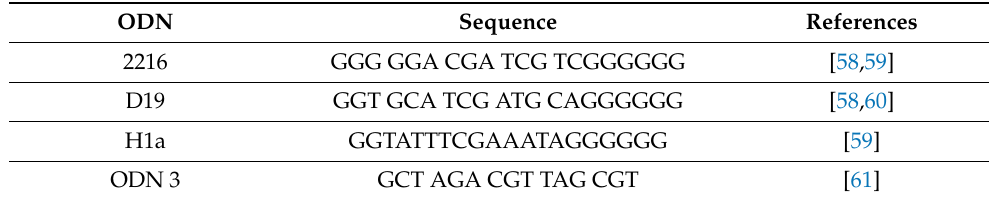
Table 1. Sequences of the ODNs selected to enrich the AcMNPV genome in specific CpG motifs for pigs. Four ODNs were selected from studies that demonstrated their immunostimulatory effects in porcine cells. The nucleotide sequences and references are shown in the